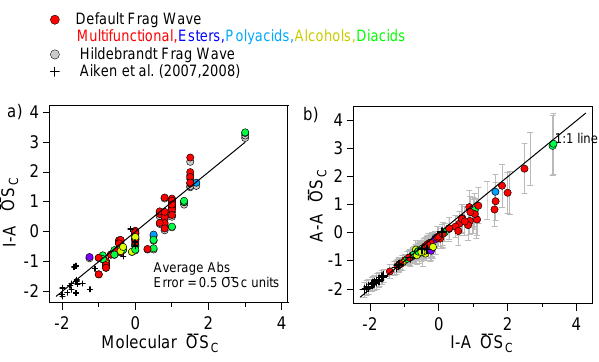
Figure 5. (a) Scatterplot of Improved-Ambient OS C values (2 × O:C – H:C) of the organic standards vs. their known molec- ular OS C values. The Improved-Ambient method was applied with the default AMS organic fragmentation wave (colored solid circles) as well as with the Hildebrandt Ruiz et al. (2014) changes to the or- ganic fragmentation wave. (b) Scatterplot of Aiken-Ambient OS C values of the organic standards vs. the corresponding Improved- Ambient method values. The error bars denote the propagated un- certainty in the Aiken-Ambient OS C values due to the uncertainties in the Aiken-Ambient O:C and H:C values. The solid line shows the 1 : 1